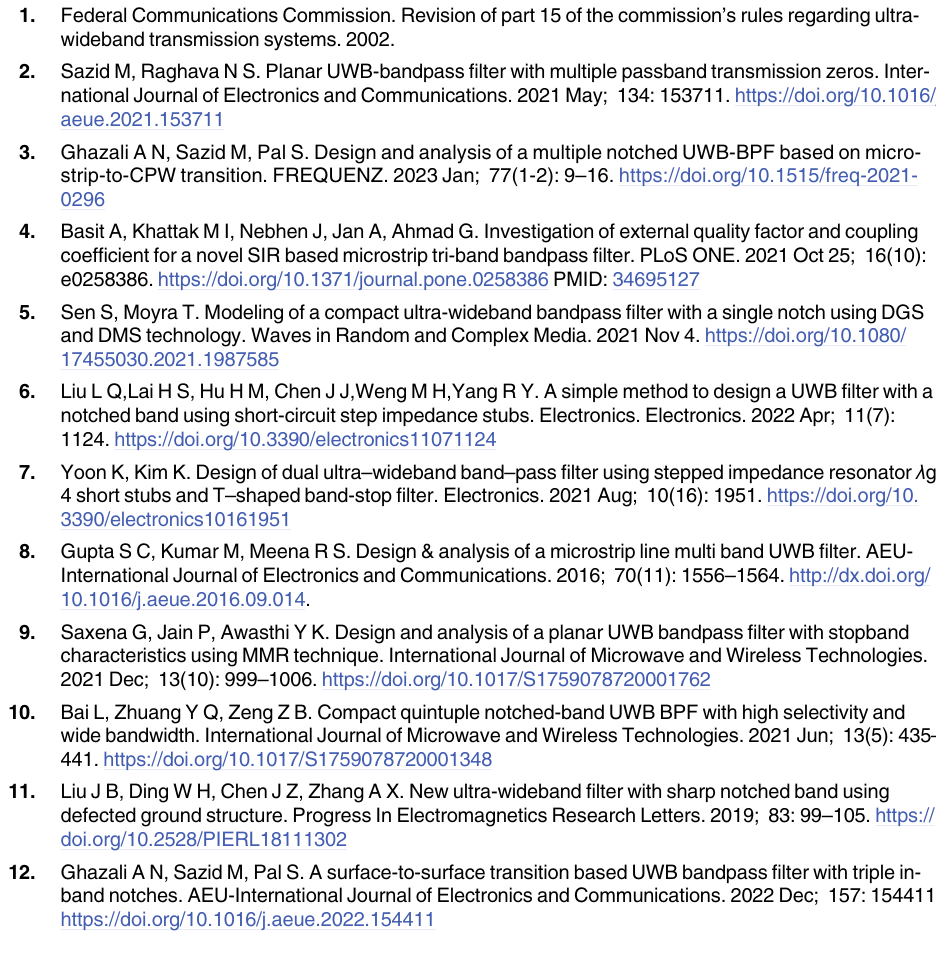
S1 Data. Comparison of measured results and simulation